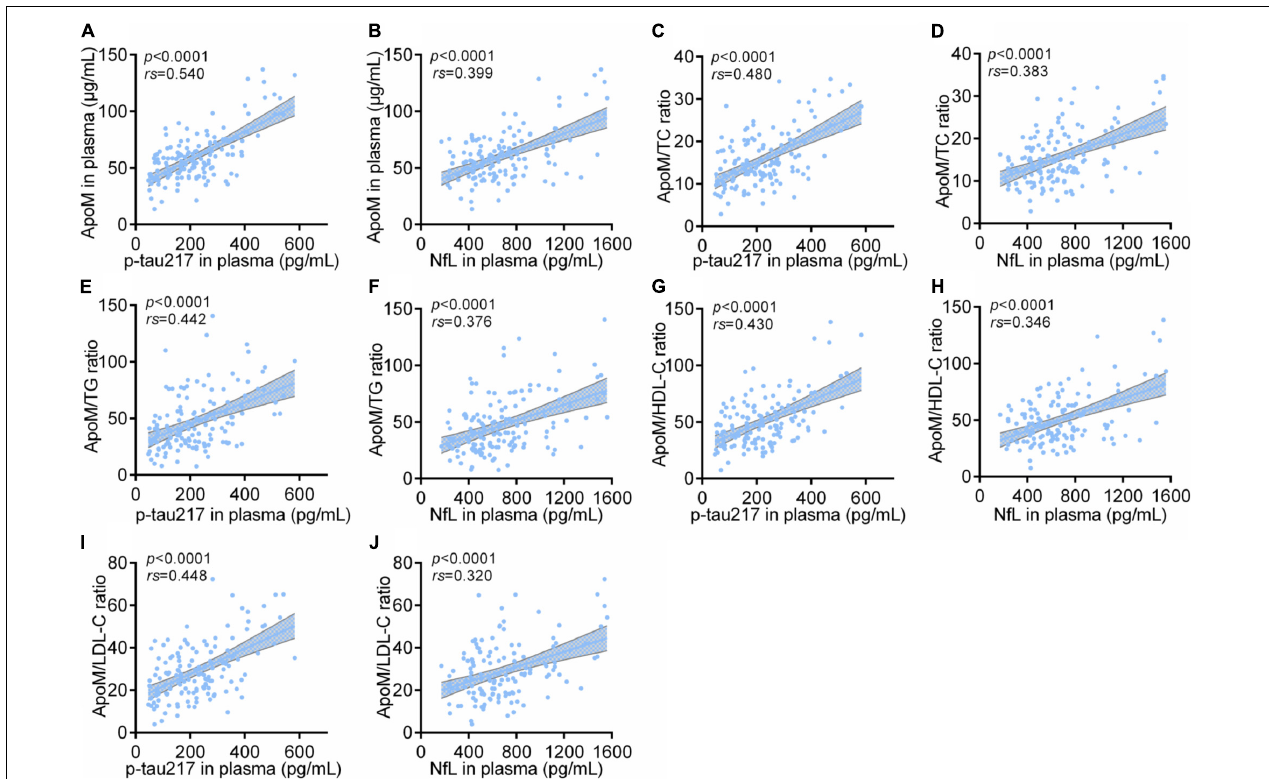
FIGURE 4 | Correlations between plasma ApoM and its derived indicators with representative blood biomarkers of AD among all participants. The correlations between plasma ApoM with plasma p-tau217 (A) and NfL (B) . The correlations between ApoM/TC ratio with plasma p-tau217 (C) and NfL (D) . The correlations between ApoM/TG ratio with plasma p-tau217 (E) and NfL (F) . The correlations between ApoM/HDL-C ratio with plasma p-tau217 (G) and NfL (H) . The correlations between ApoM/LDL-C ratio with plasma p-tau217 (I) and NfL (J) . ApoM, apolipoprotein M; p-tau217, tau phosphorylated at threonine 217; NfL, neurofilament